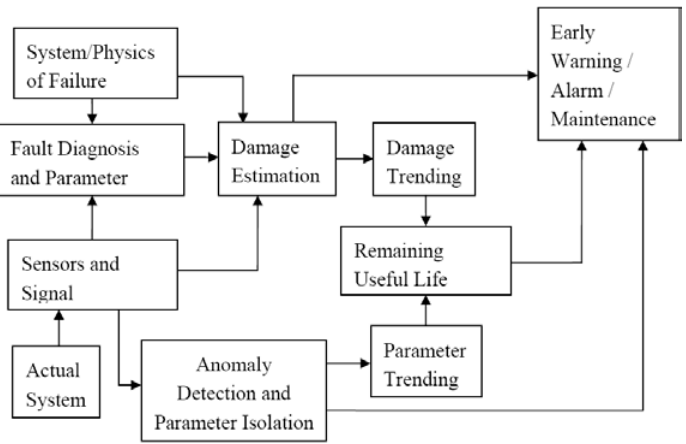
Figure 3. Block diagram of a fusion